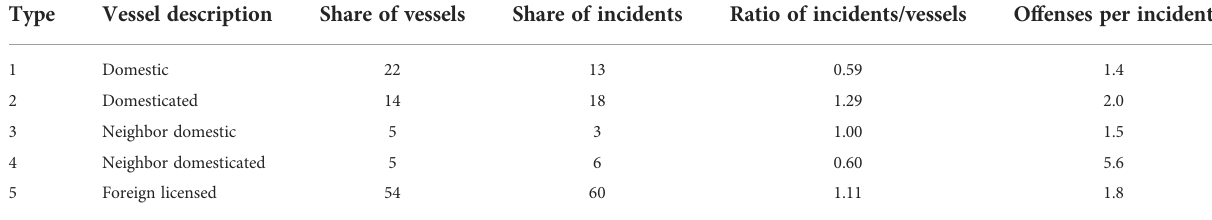
TABLE 3 Ratio of incidents to vessels by adjacency